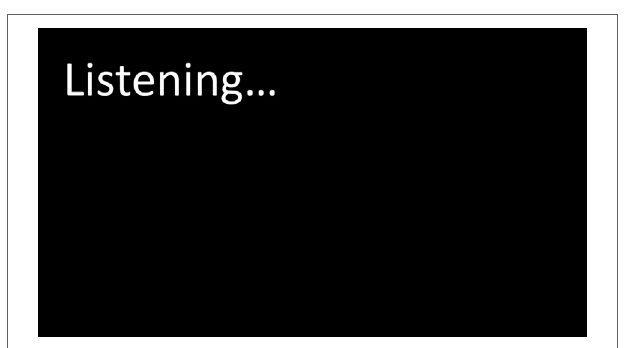
FigUre 3 | The Holli user interface while in listening mode.